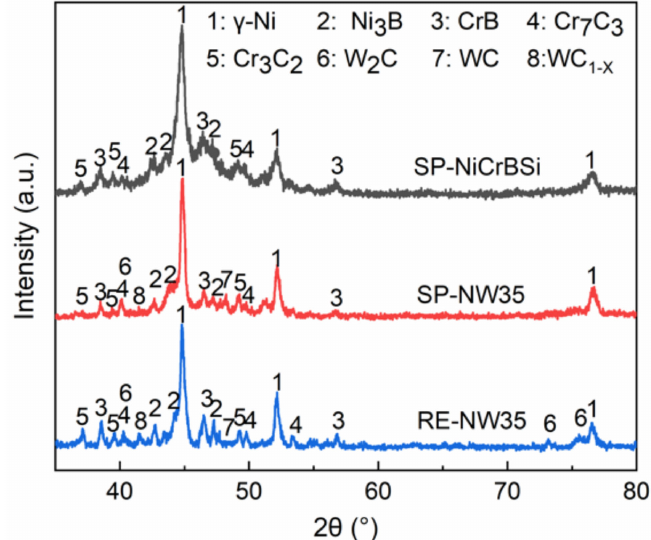
Figure 1. XRD patterns of the SP-NiCrBSi, SP-NW35 and RE-NW35 coatings. SP-NiCrBSi and SP-NW35 indicates the as-sprayed NiCrBSi and NiCrBSi / WC coatings; RE-NW35 means the remelted NiCrBSi / WC